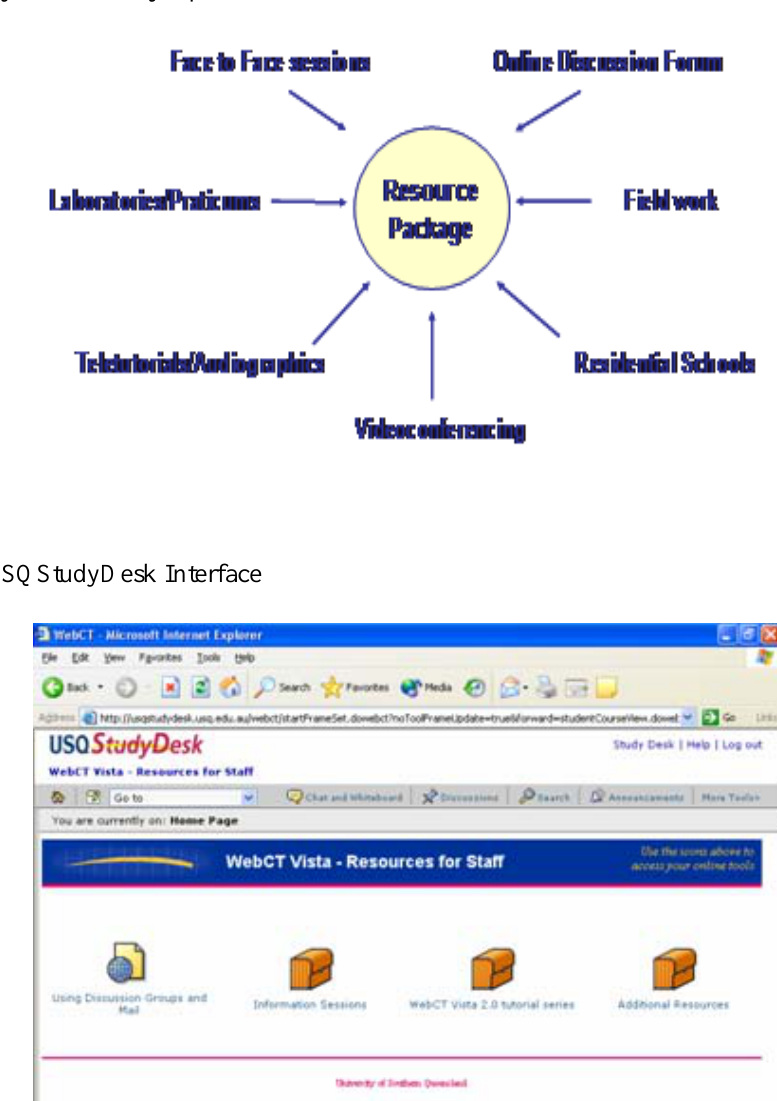
Figure 6. Hybrid Delivery Options